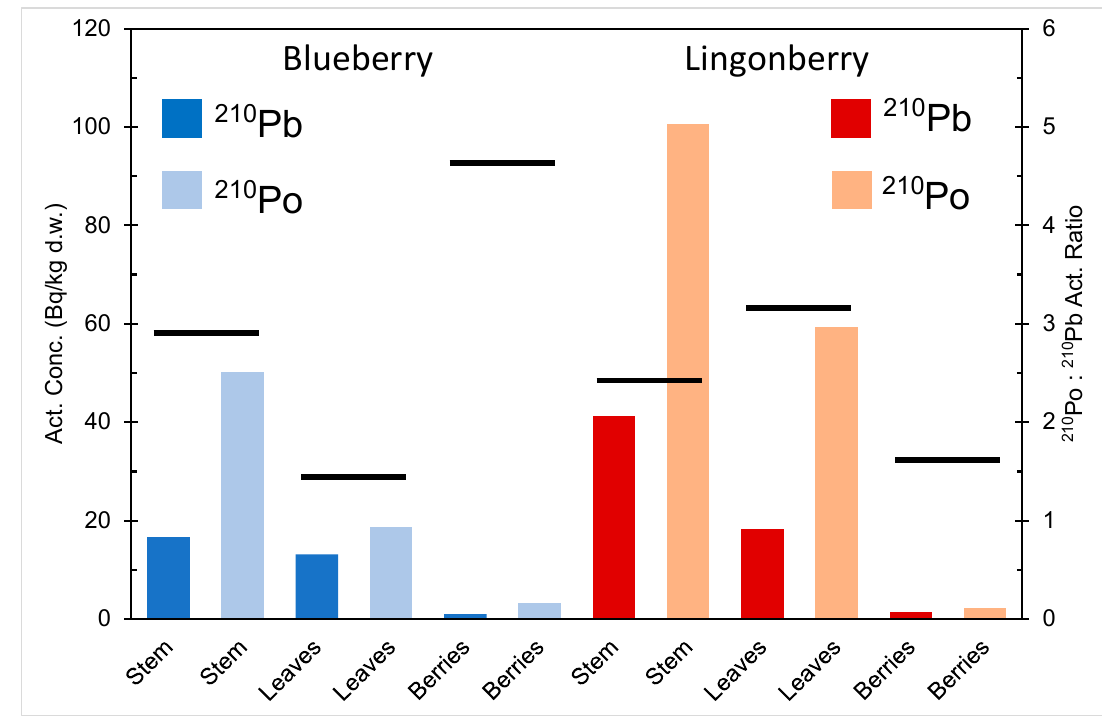
Figure 3. 210 Pb and 210 Po activity content in different parts of blueberry ( V. myrtillus ) and lingonberry ( V. Vitis-idaea ) in northern Finland, drawn from the data in [17]. The black lines denote the 210 Po: 210 Pb activity ratios: a vertical scale on the right.